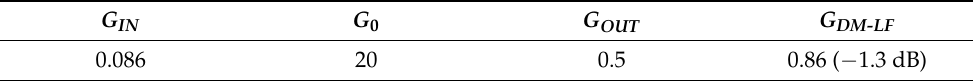
Table 8. Low-frequency gains of the conditioning circuit (from Equation (11)).